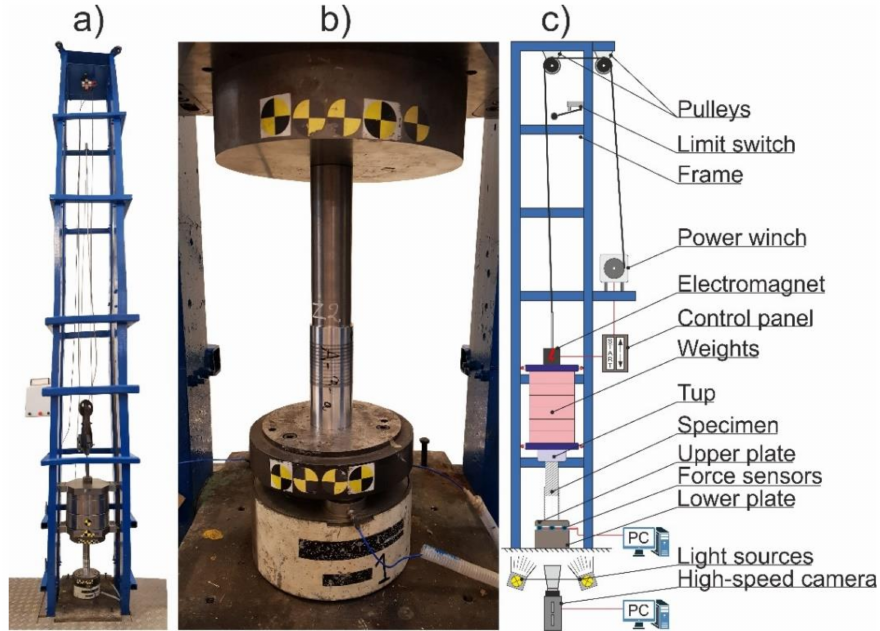
Figure 2. Gravity drop hammer: ( a ) photograph; ( b ) position of the specimens; ( c )